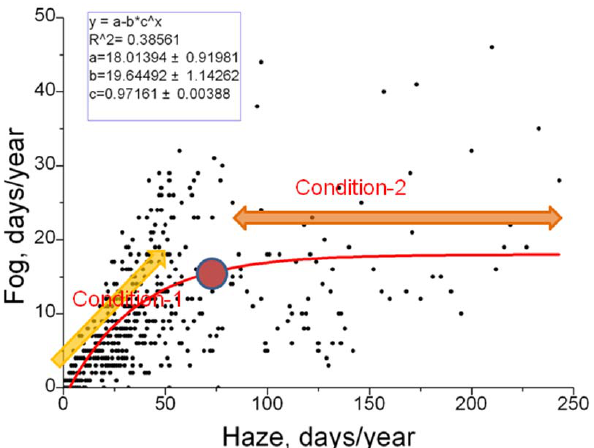
Fig. 4. The correlation between averaged fog and haze day occur-